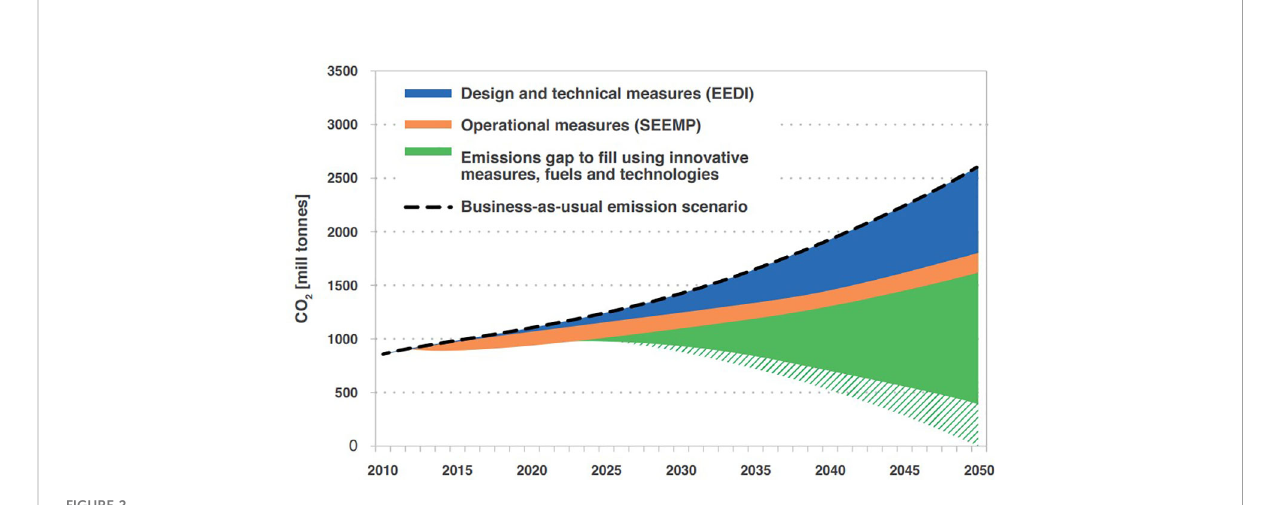
FIGURE 2 IMO GHG reduction pathway. Source: IMO (2020a).